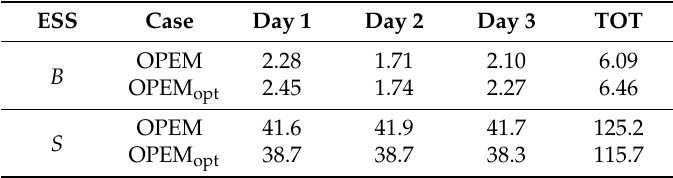
Table 8. HESS cycling performance achieved by OPEM (in cycles).